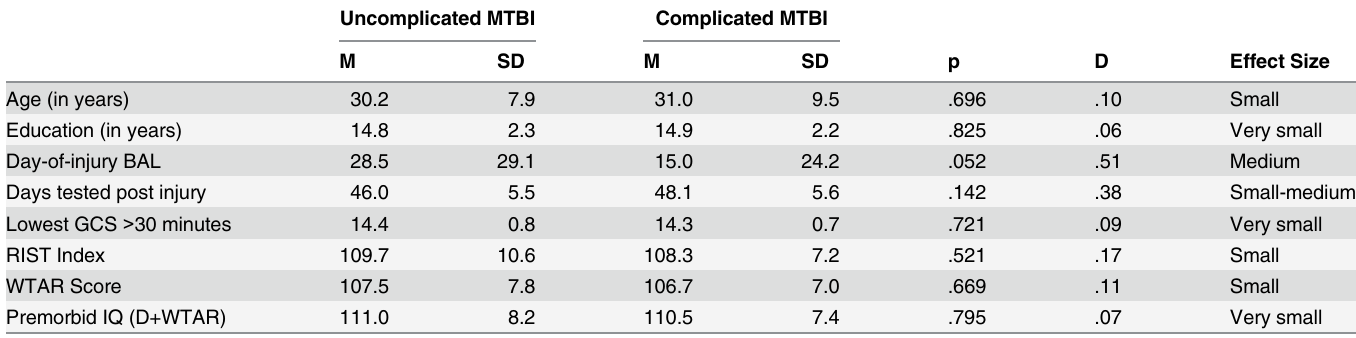
Table 2. Descriptive statistics, group comparisons, and effect sizes of demographic and injury severity characteristics (continuous variables) by